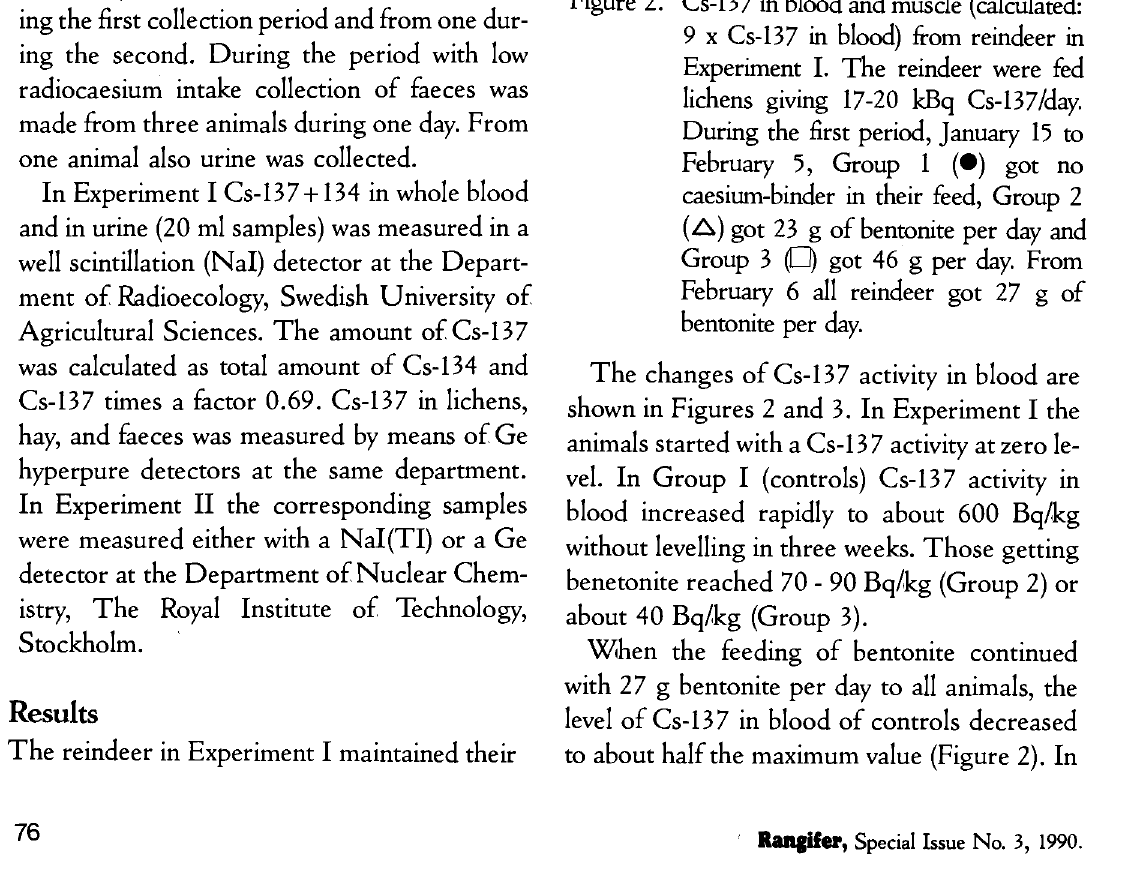
Figure 2. Cs-137 in blood and muscle (calculated: 9 x Cs-137 in blood) from reindeer in Experiment I. The reindeer were fed lichens giving 17-20 kBq